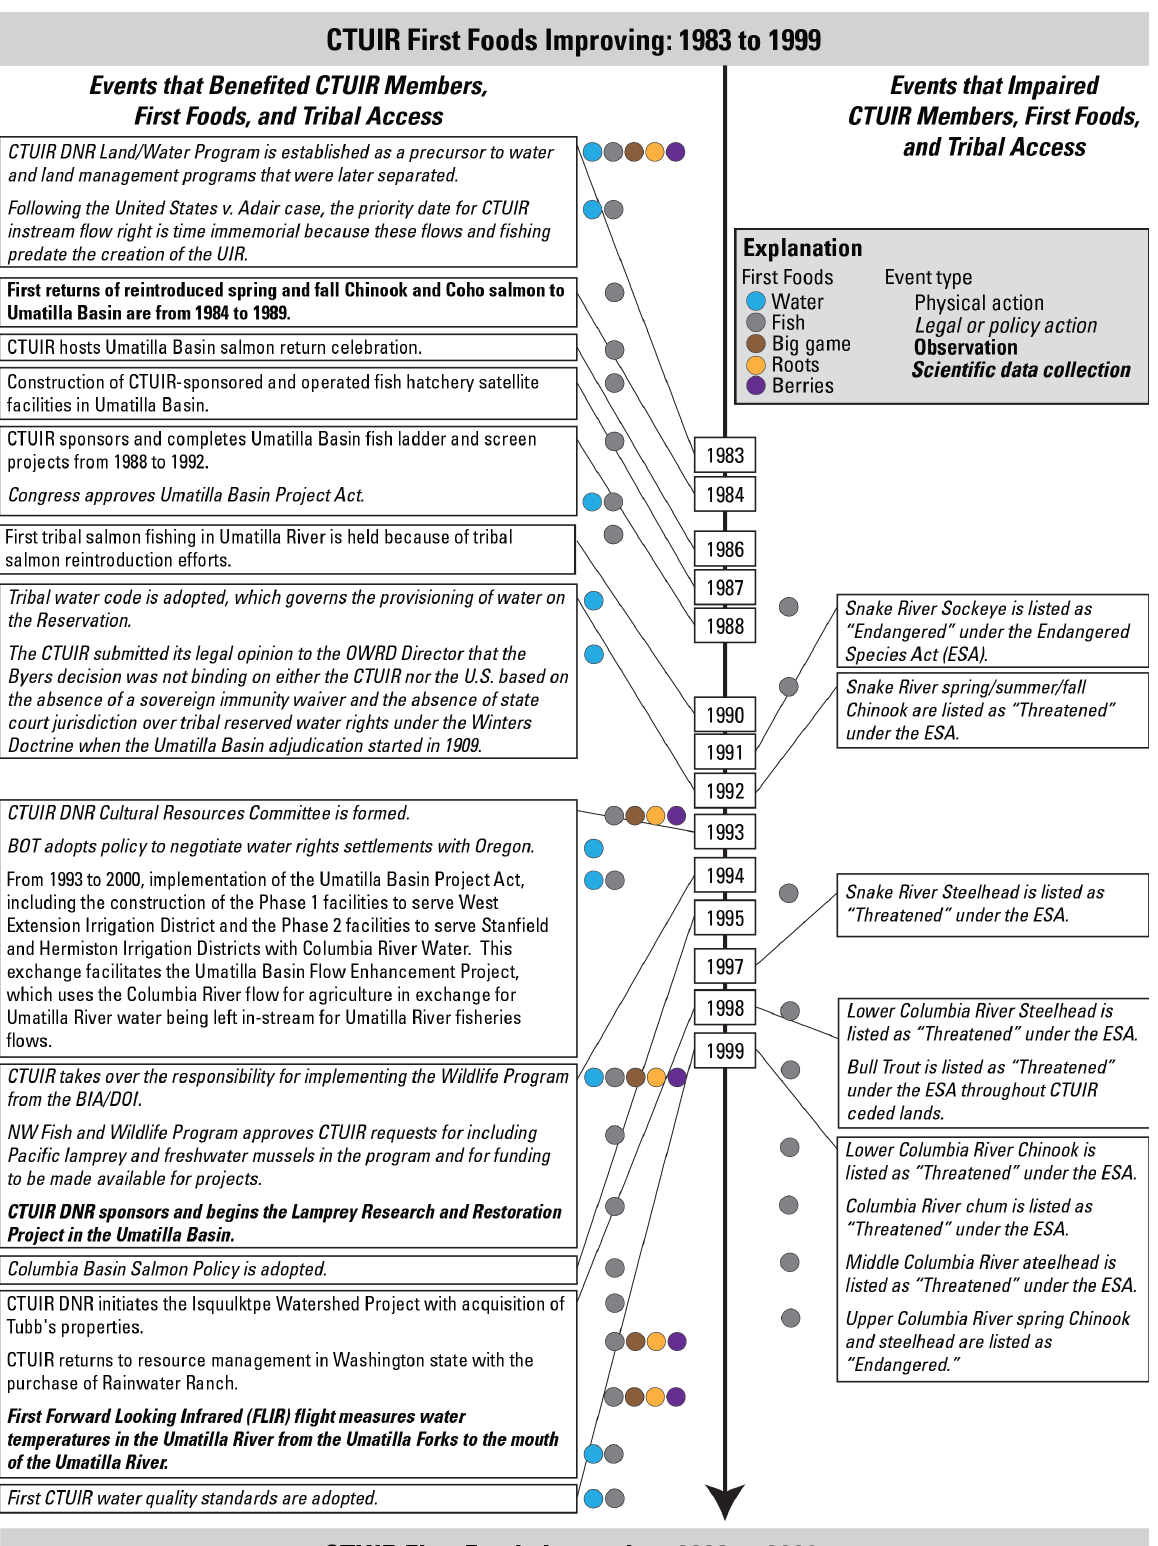
Fig. 7 . Timeline of representative events benefiting or diminishing First Foods and tribal access to them, 1983 to